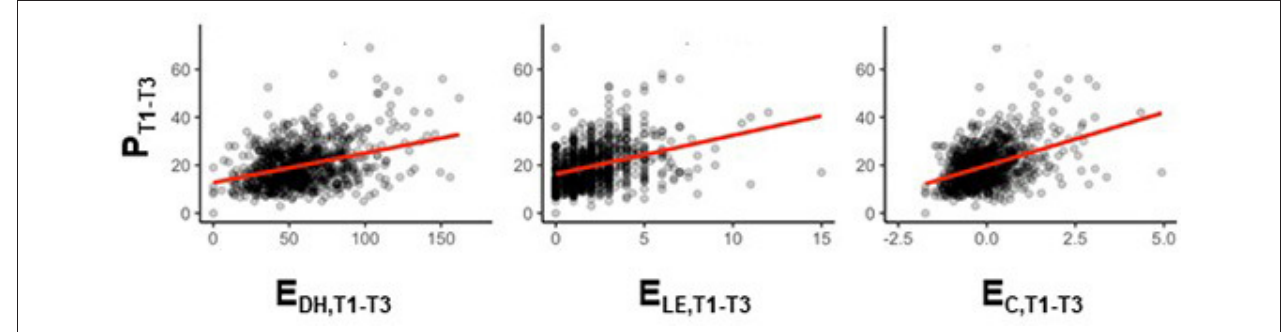
FIGURE 3 | Hypothetical relationship between stressor exposure (E) and mental health problems (P) in the example study. LE and DH counts as well as total mental health problem sum scores P are averaged over the first 3 three-monthly monitoring time points after study inclusion (T0), that is: T1 (month 3), T2 (month 6), and T3 (month 9), to obtain stressor exposure scores E DH,T1 − T3 (left column) and E LE,T1 − T3 (middle column) and mental health problem score P T1 − T3 . E C,T1 − T3 is a combined stressor exposure score (mean of E LE and E DH z-scores; right column).